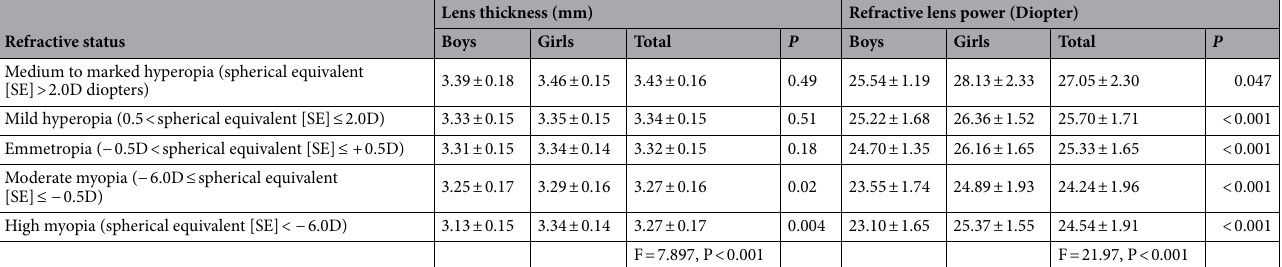
Table 4. Lens thickness and refractive lens power stratified by the refractive status and sex.